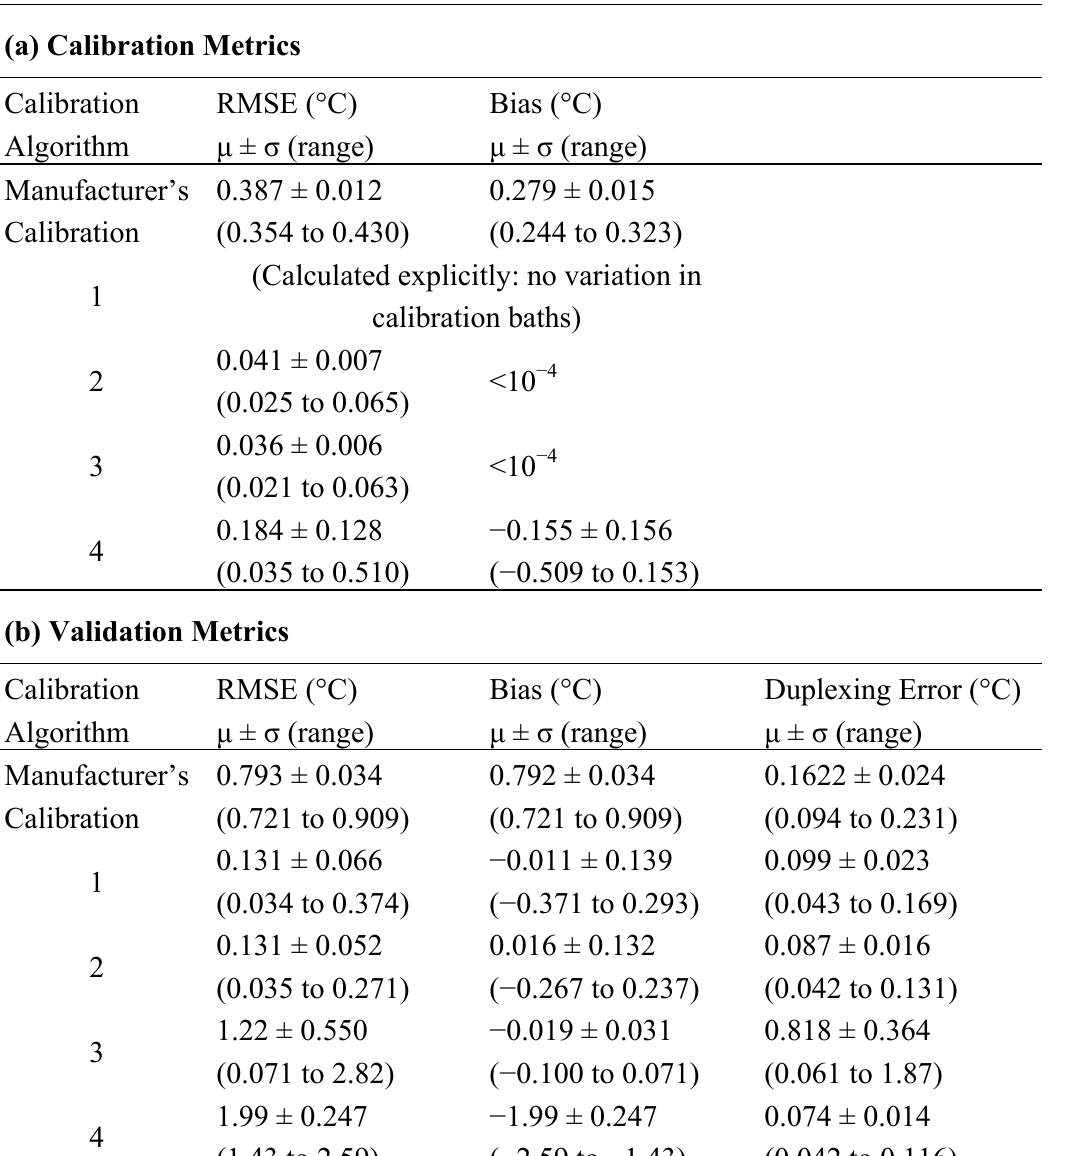
Table 2. Calibration Metrics for the Salt-Gradient Solar Pond (n = 575, 1 m spatial sampling interval, 300 s integration time, 16 points in each reference and validation section). (a) Calibration metrics recorded in the calibration baths. (b) Calibration metrics for the validation baths. While the manufacturer’s calibration did not include the step loss correction, the 4 sample calibration algorithms were run on the corrected